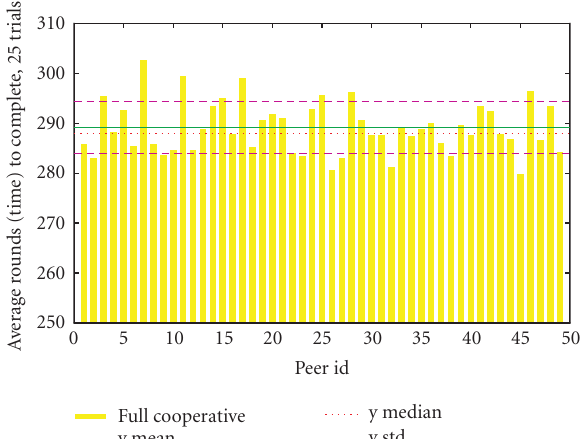
Figure 5: 50 full cooperative peers’ download times (rounds), aver- aged over 25 streams.